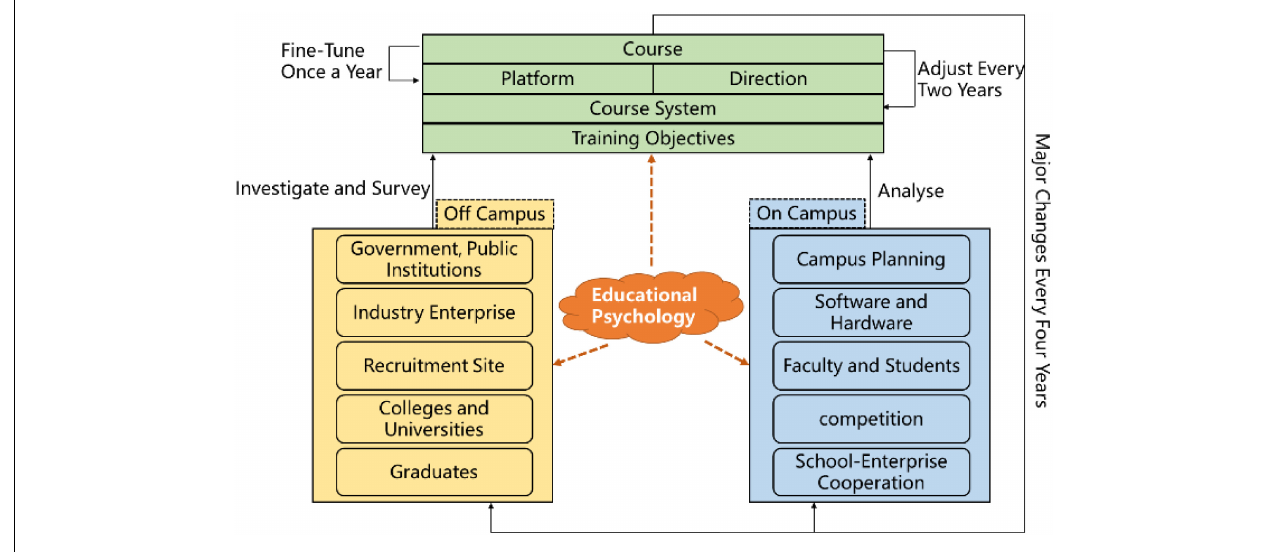
FIGURE 1 | Development and adjustment process of talent cultivation program.